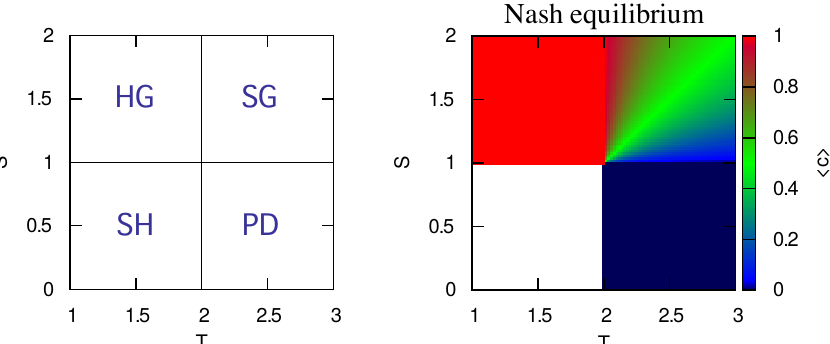
Figure 1. Two-dimensional ( S , T ) representation of the symmetric two-player two-action games for P = 1, R = 2, 0 < S < 2 and 1 < T < 3. ( a ) The left panel shows the location of the four types of games; ( b ) the right panel shows (color code shown at right) the average level of cooperation in the corresponding Nash